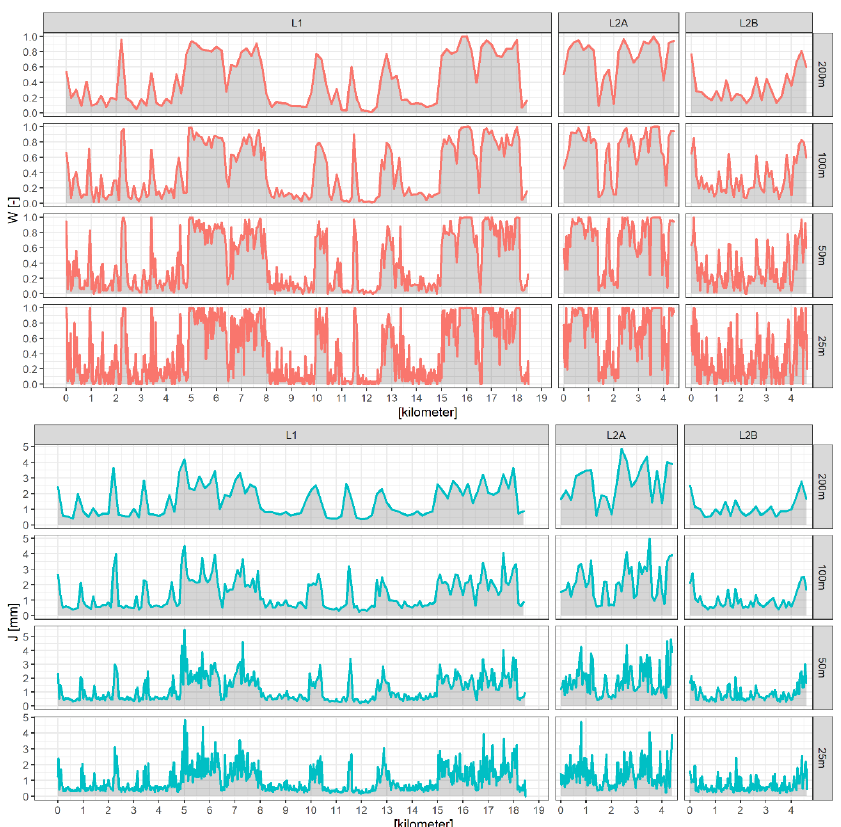
Figure 7. Distribution of the synthesized tram-track quality index W and J.